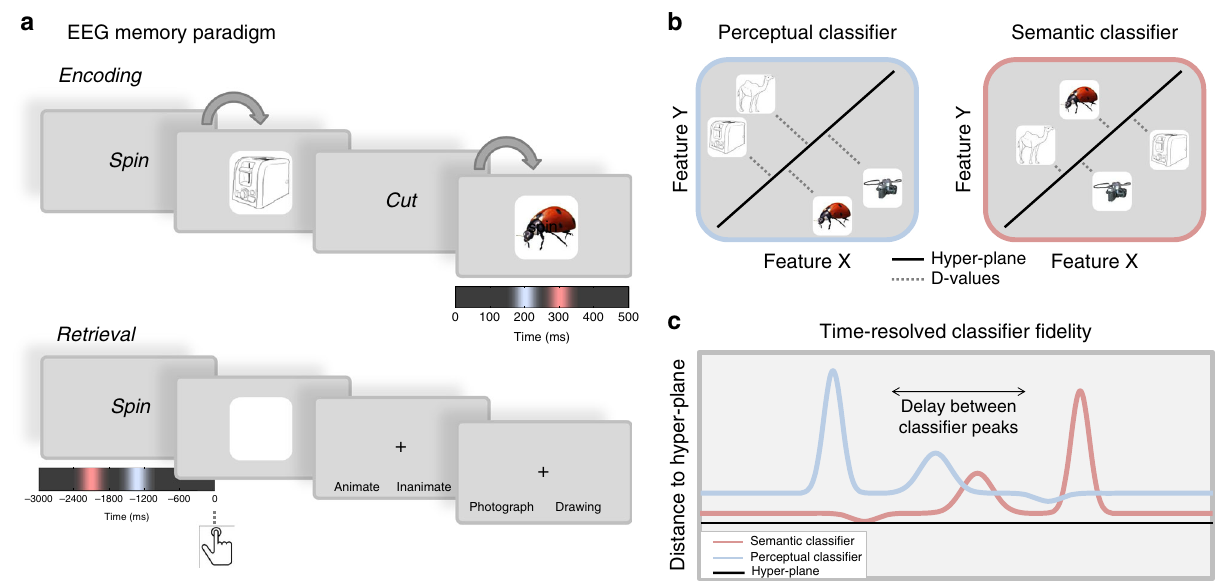
Fig. 3 Design for EEG experiment and time-resolved multivariate decoding. In the EEG experiment participants were asked to create word-object associations (panel a ), and to later reconstruct the object as vividly as possible when cued with the word, and to indicate with a button press when they had a vivid image back in mind. EEG was recorded during learning and recall, with the aim to perform time-series decoding analyses that can detect at which moment, within a single trial, a classi fi er is most likely to categorise perceptual and semantic features correctly. Coloured time lines under object and cue time windows represent our reversal hypothesis regarding the temporal order of maximum semantic (pink) and perceptual (blue) classi fi cation during the perception (encoding) and retrieval of an object. All EEG analyses were aligned to the object onset during encoding, and to the button press during retrieval. b Decoding analyses were performed independently per participant at each time point. For each given time point during a trial, two linear discriminant analysis (LDA)-based classi fi ers were trained on the EEG signal: one perceptual classi fi er discriminating photographs from line drawings, and one semantic classi fi er discriminating animate from inanimate objects. Classi fi ers were tested using a leave-one-out procedure, which allowed us to obtain a time series of con fi dence values ( d values, re fl ecting the distance from the separation hyperplane) for each single trial. c Our main interest was to compare the time points of maximal fi delity of the perceptual (blue) and semantic classi fi ers (pink) on each trial, to test the hypothesis that the perceptual maximum (blue) precedes the semantic one (pink) during perception, and importantly that this order is reversed during memory